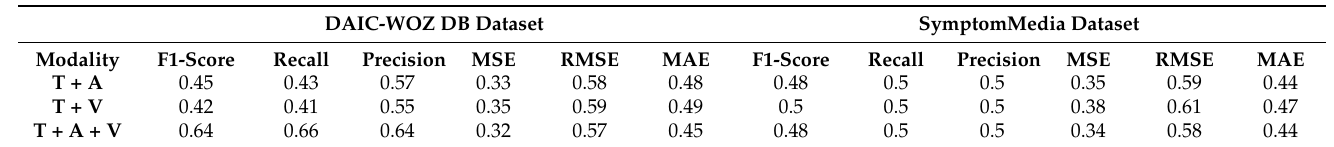
Table 8. The performance and error metrics for the LSTM with gating (T + A: text and audio; T + V: text and video; T + A + V: text, audio, and